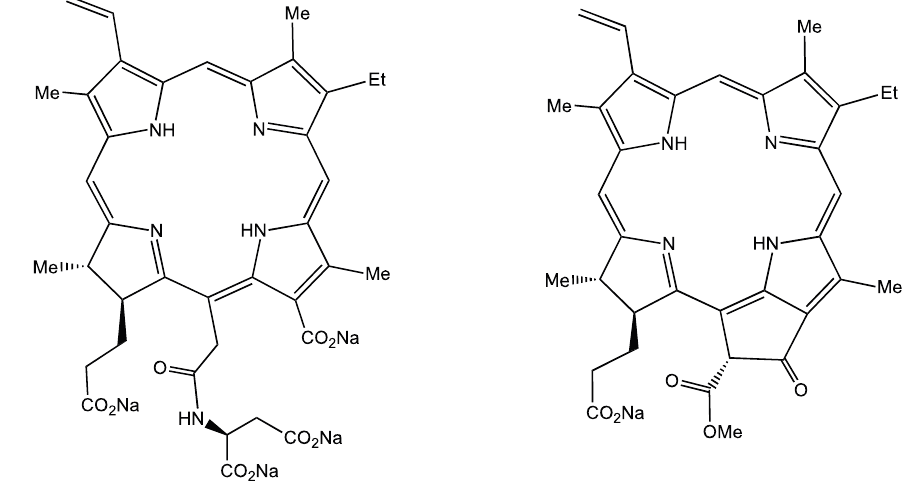
Figure 1. Chemical structure of talaporfin sodium ( left ) and sodium-pheophorbide a ( right